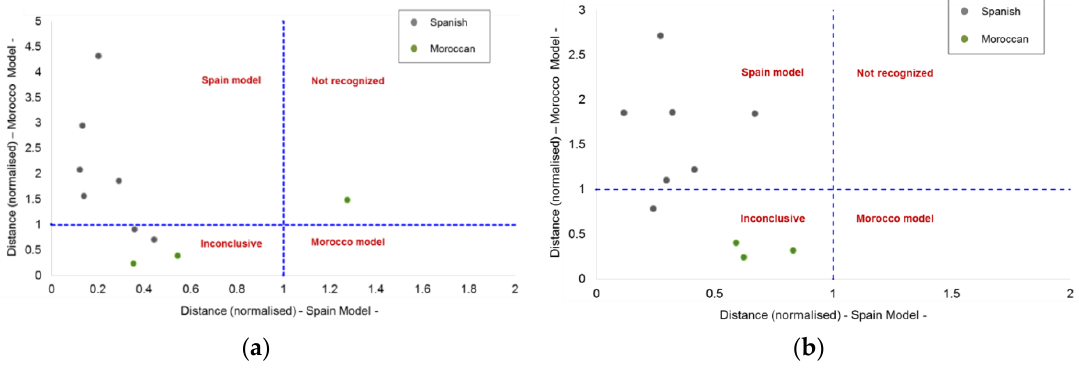
Figure 3. Coomans’ plot from ( a ) normal and ( b ) reverse liquid chromatography coupled with diode-